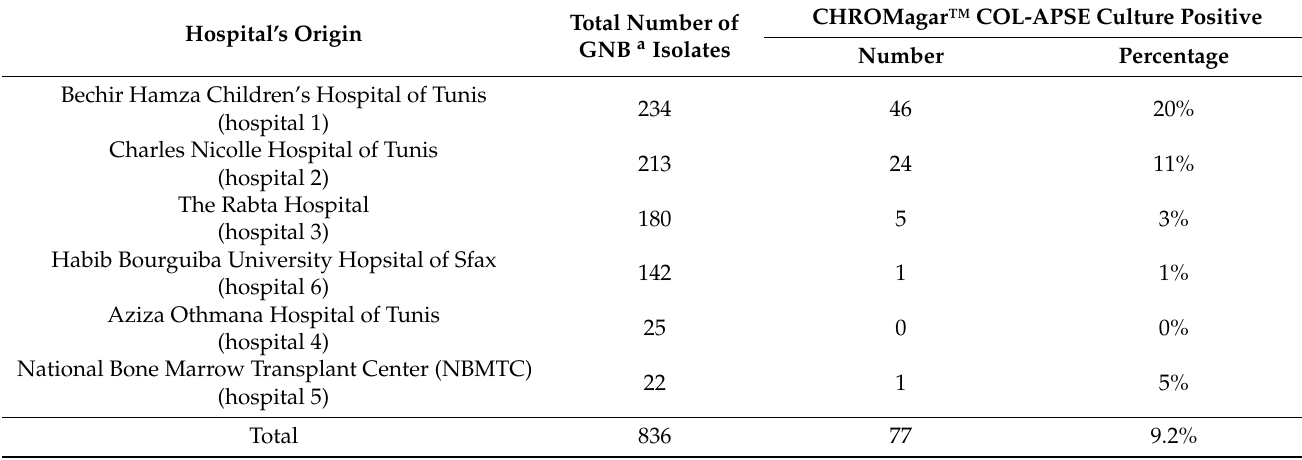
Table 1. Distribution of GNB isolates according to their hospital